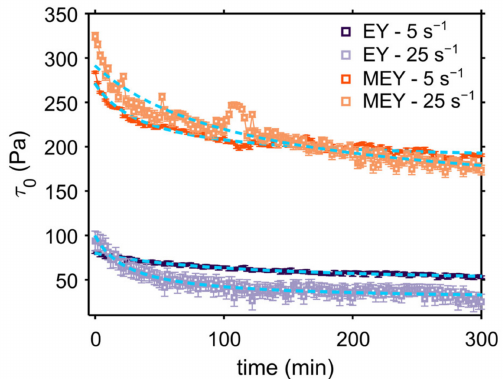
Figure 3. Yield stress values of EY and MEY emulsions as a function of shearing time at 5 s − 1 and 25 s − 1 and SKM fitting curves (dashed blue lines). Plotted error bars correspond a Herschel- Bulkley fitting error and refer to a single experiment. For each formulation, the relative standard deviation errors for duplicates are in the order of 10